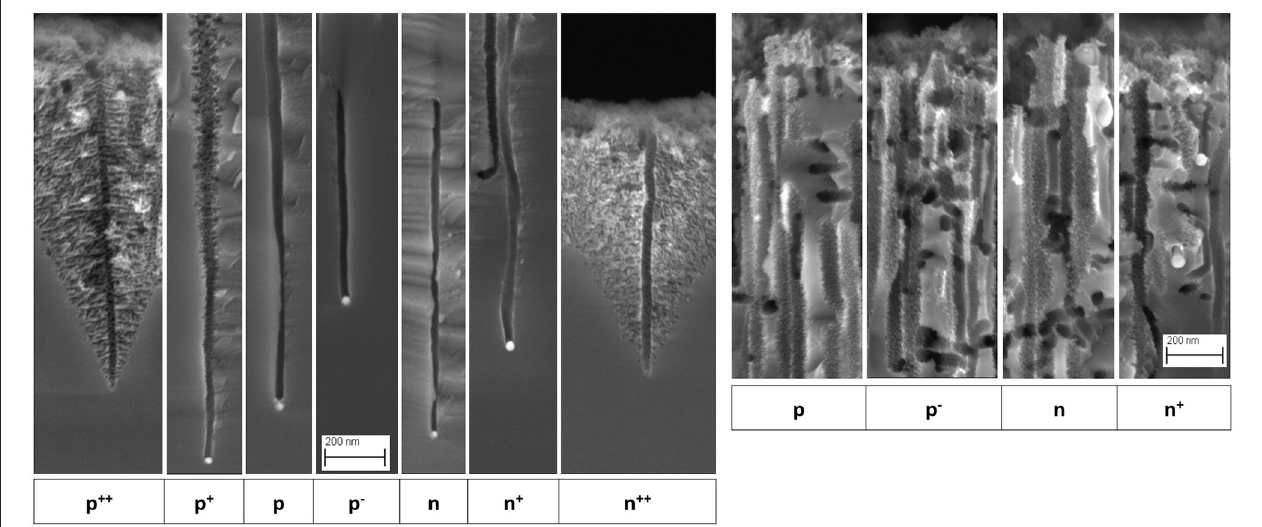
FIGURE 2 | SEM images of mesopore tips ( left ) and tops ( right ), for the different substrate dopings. Same magnification for all images of each group. Note that the presence or absence of a nanoparticle at a pore tip is only a random result of cutting the sample for cross-sectional SEM imaging (depending on whether it remains stuck to the observed piece). Scale bar: